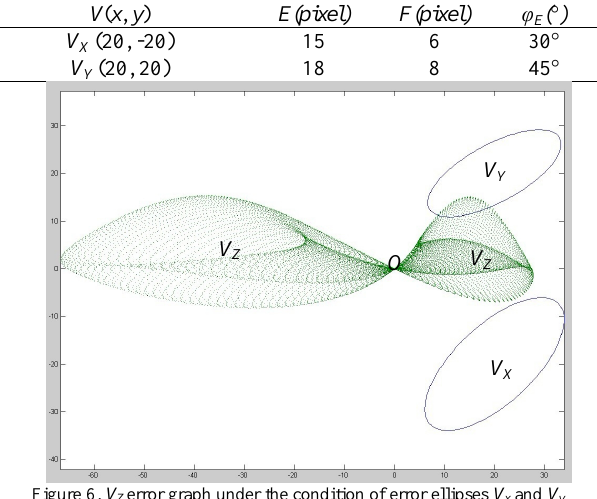
Figure 6. V Z error graph under the condition of error ellipses V x and V